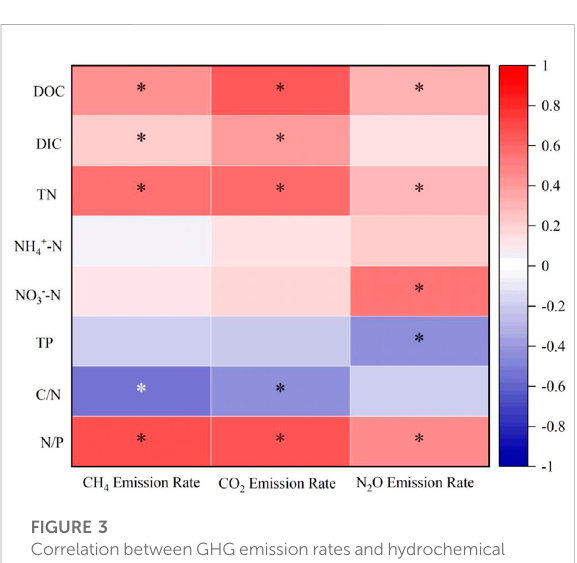
FIGURE 3 Correlation betweenGHGemission rates and hydrochemical parameters for microcosm incubation, where * represent the p values ( < 0.05) of signi fi cant